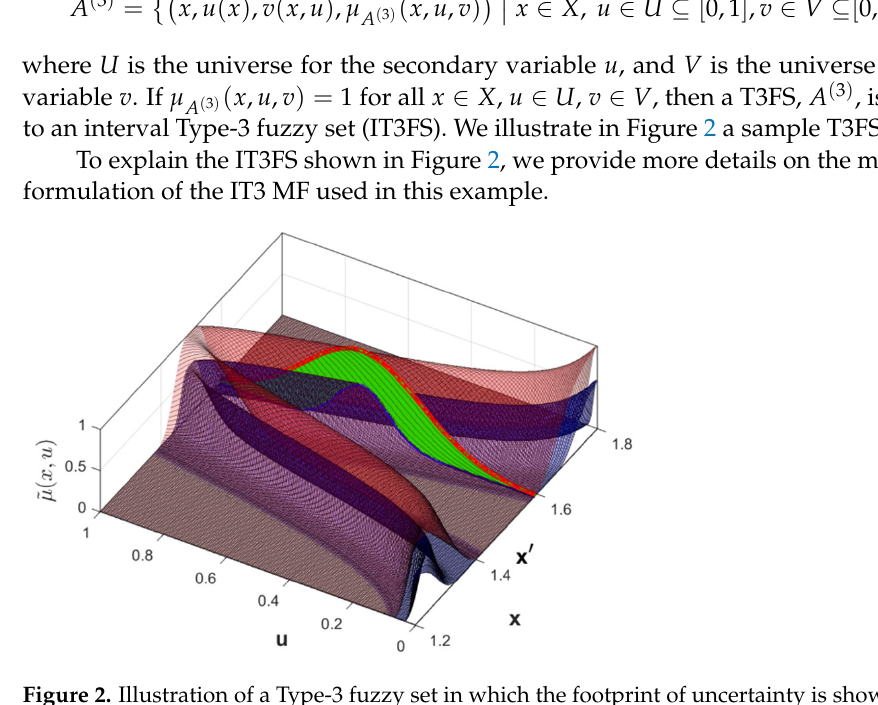
Figure 2. Illustration of a Type-3 fuzzy set in which the footprint of uncertainty is shown in green.